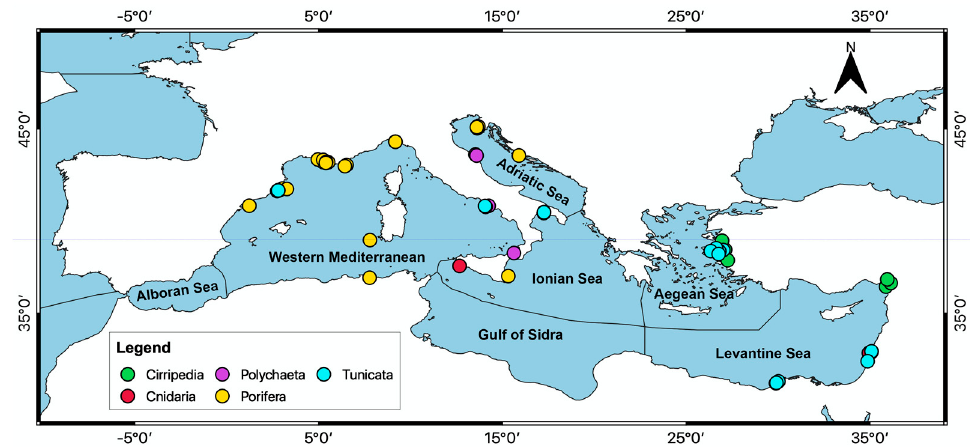
Figure 6. Map of the distribution of documents per taxa in each ecoregion of the Mediterranean Sea.